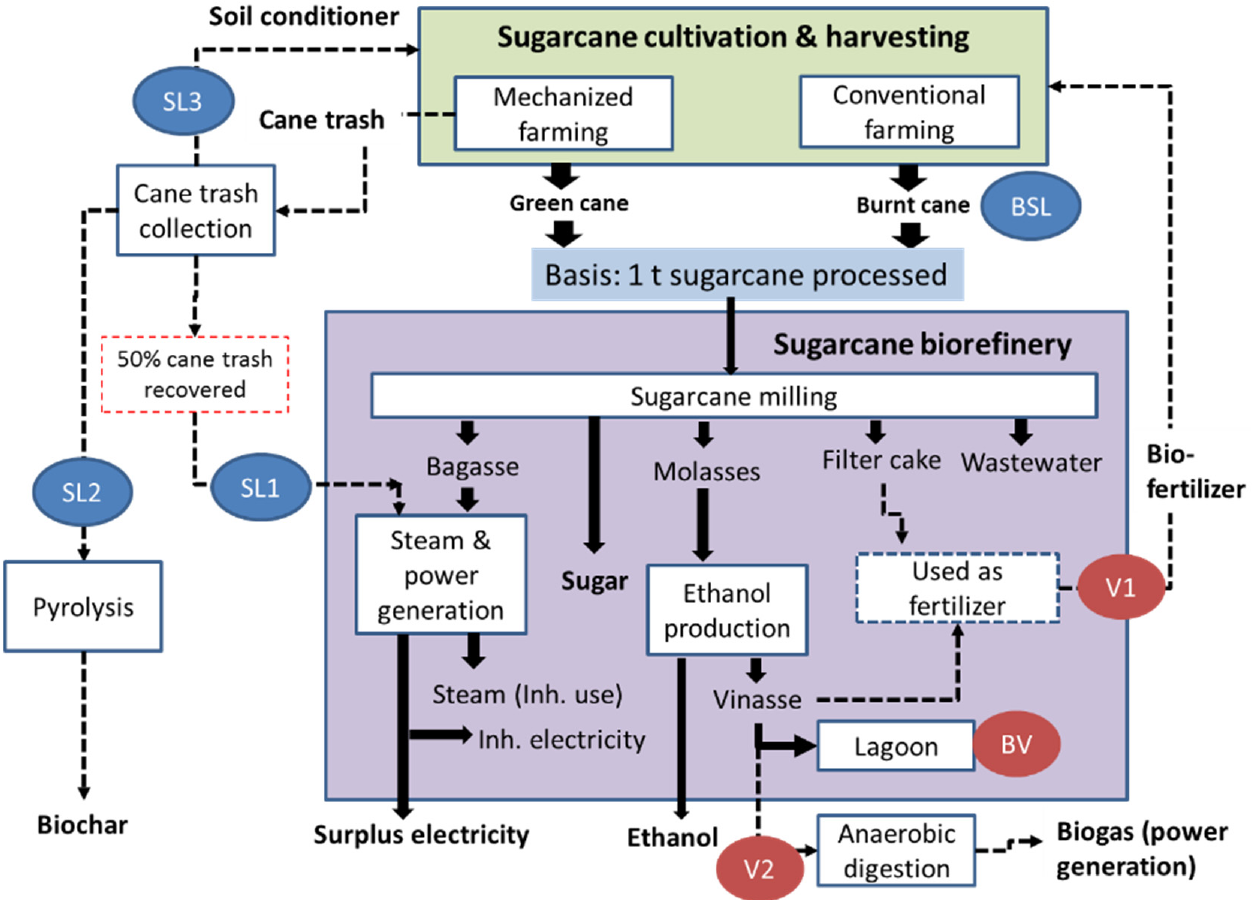
Figure 1. System boundary of the sugarcane biorefinery system under different waste utilization scenarios.